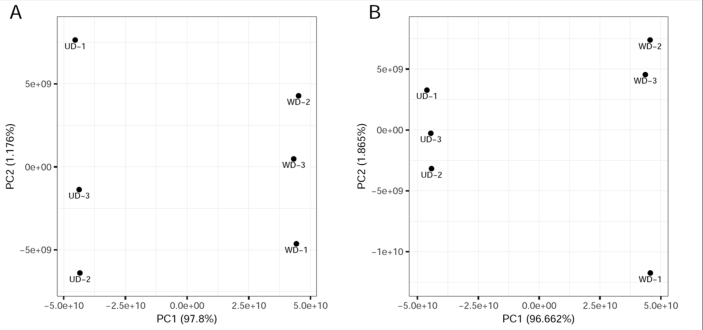
The first and second principal components derived from PCA of un-differentiated normal human primary bronchial/tracheal epithelial cells and well-differentiated cells. Percentages in parentheses represent the proportion of variances for PC1 or PC2. (A) Proteins with missing intensity values in any of the 6 samples were excluded. (B) All identified proteins were used after the imputation of missing values; UD and WD: un-differentiated and well-differentiated normal human primary bronchial/tracheal epithelial cells.